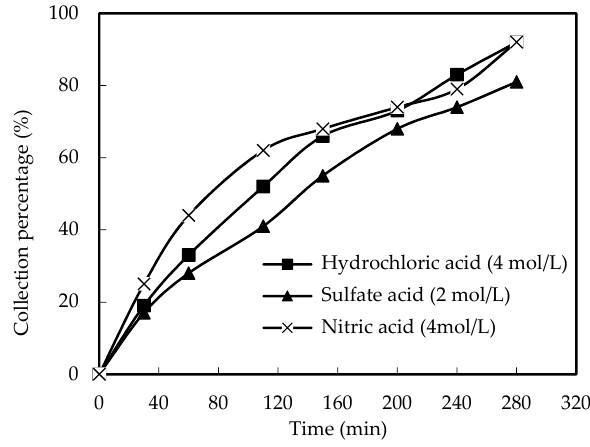
Figure 7. Influence of different acid fluids as resolving reagents.